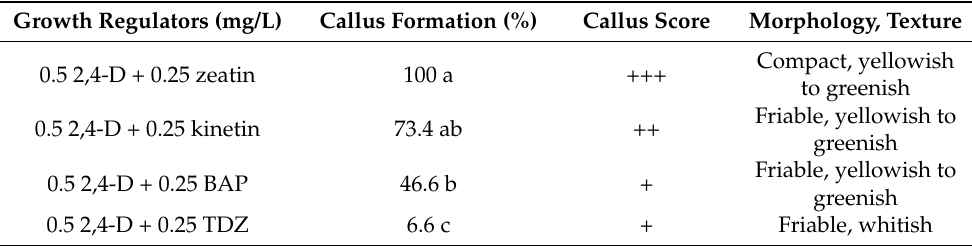
Table 3. The effects of 0.5 mg/L 2,4-D and 0.25 mg/L different cytokinins on callus induction